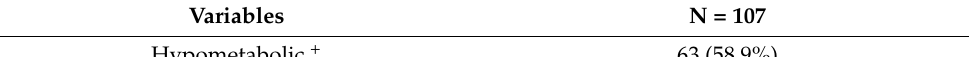
Table 2. Cont . Variables N = 107 Hypometabolic + 63 (58.9%) Hypermetabolic + 24 (22.4%)